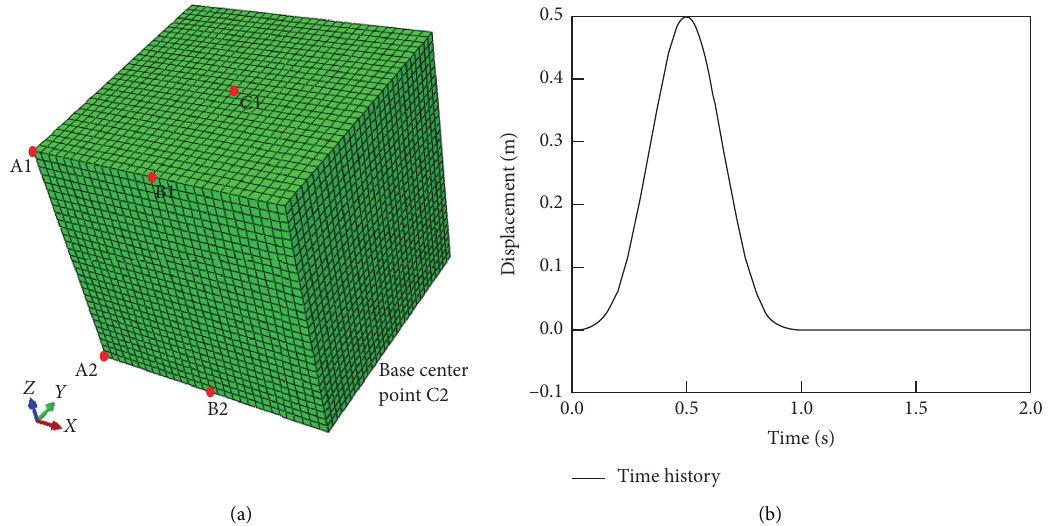
Figure 6: Verification of free-field employing a displacement pulse: (a) free-field finite element model; (b) time history of the input displacement